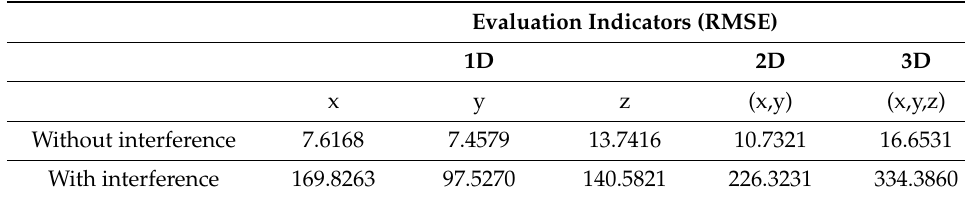
Table 3. Main index comparison results.